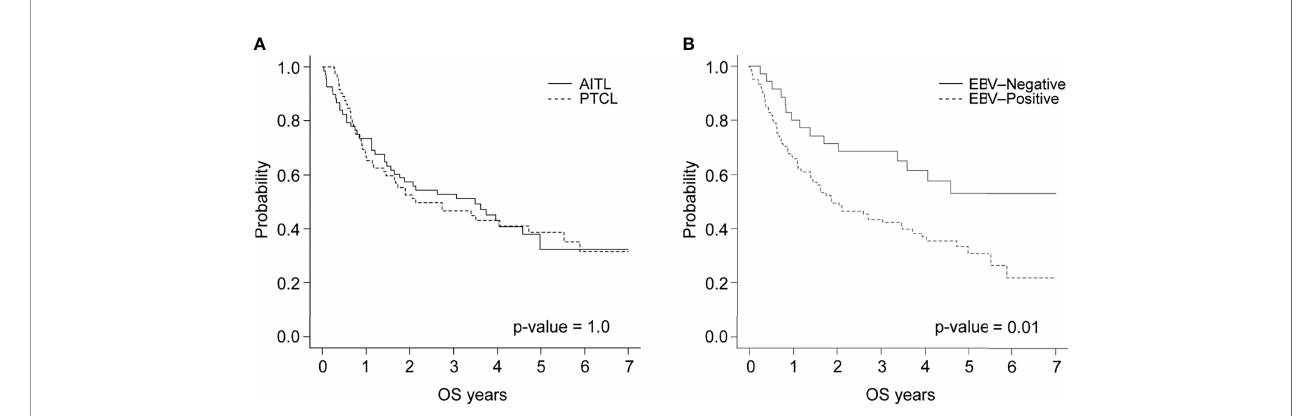
FIGURE 1 | Overall survival by (A) tumor subtype and (B) EBV status.